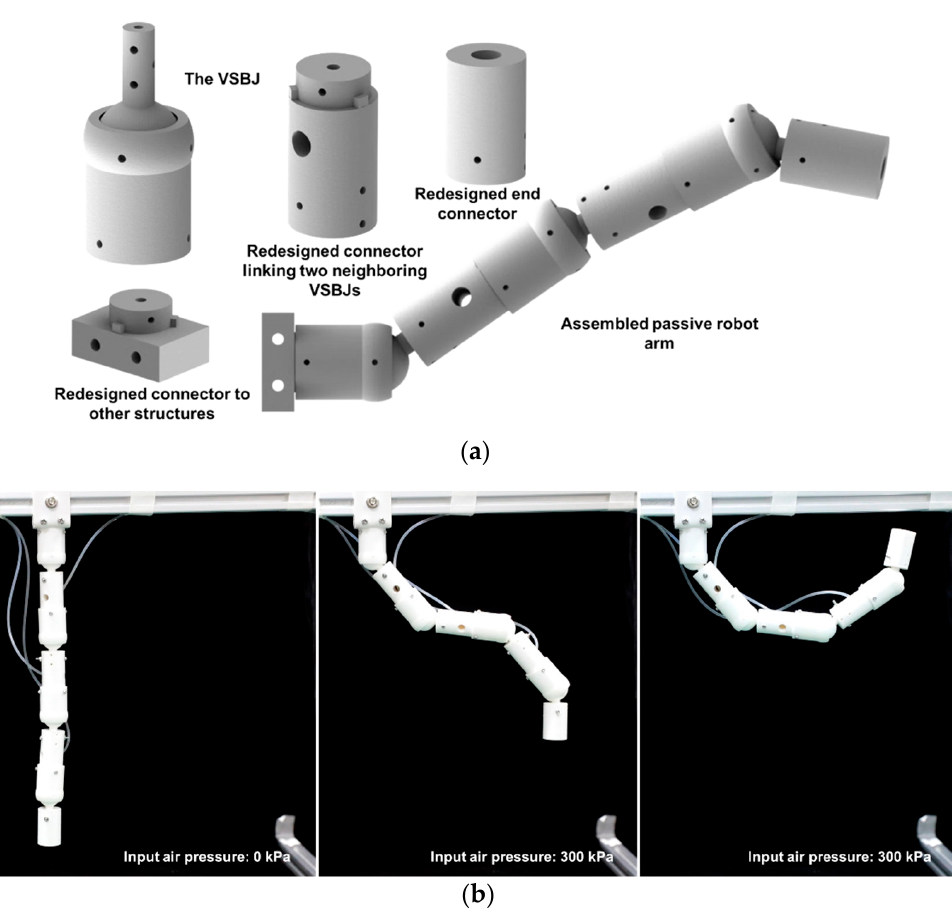
Figure 12. The modularization of the VSBJ: ( a ) Schematic illustration of the redesigned connectors; ( b ) assembled passive robot arm with variable stiffness including four VSBJs and three links.